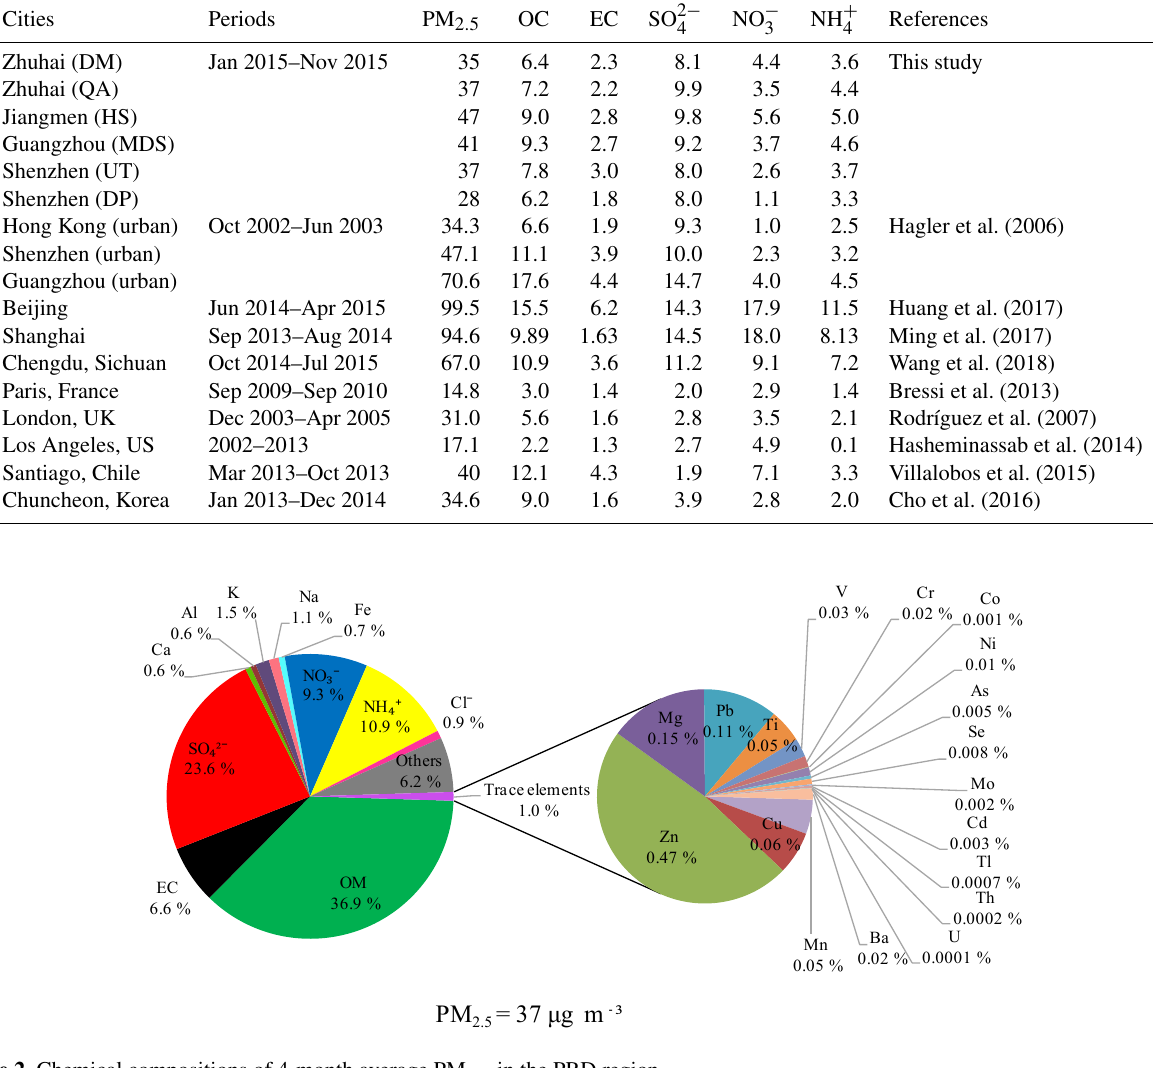
Figure 2. Chemical compositions of 4-month average PM 2 . 5 in the PRD